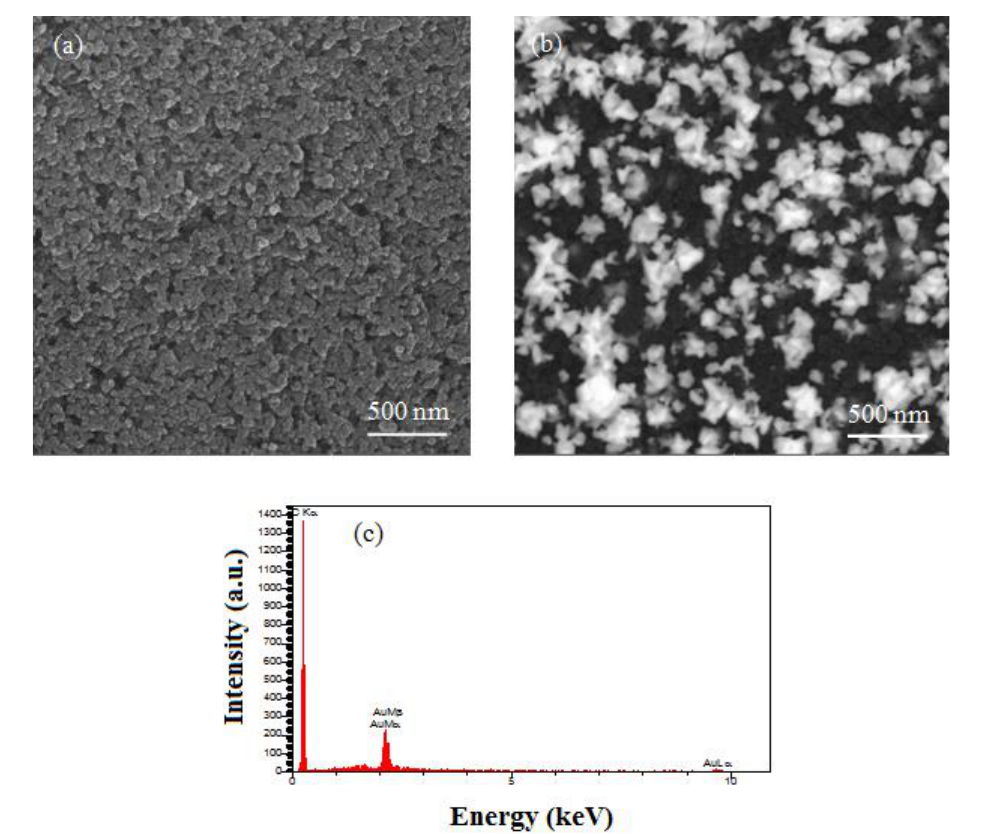
Figure 1. SEM image of (a) bare SPCE, (b) AuNPs electrodeposited on SPCE and (c) EDS analysis of AuNPs - SPCE.